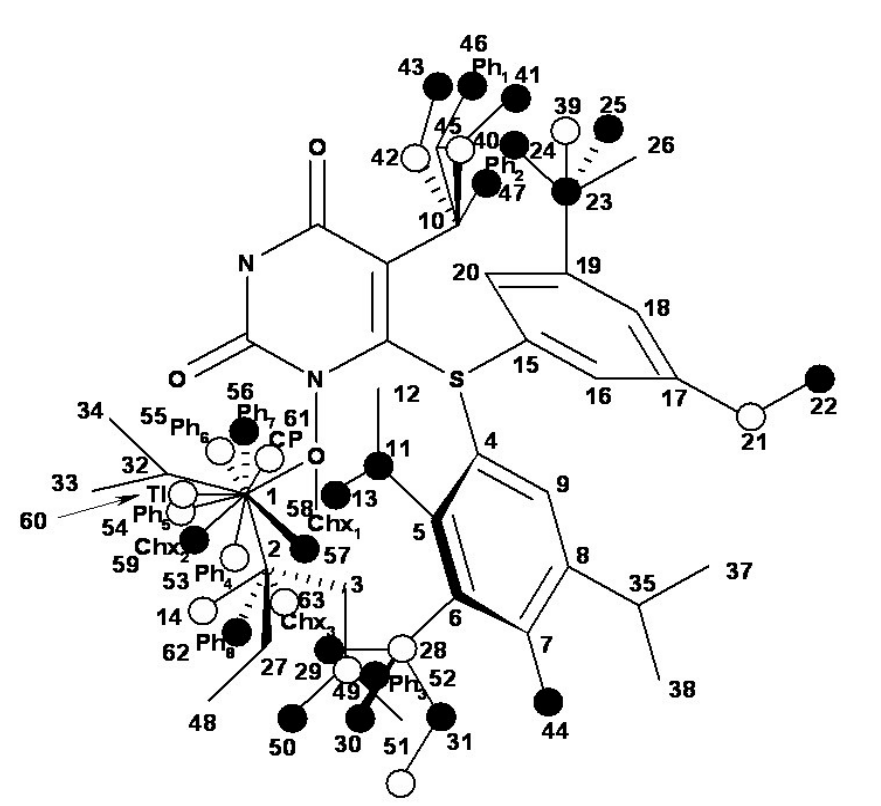
Figure 7. The occupancy of the hypermolecule vertices within the bilinear MTD model given by equation (14) and the optimized chart